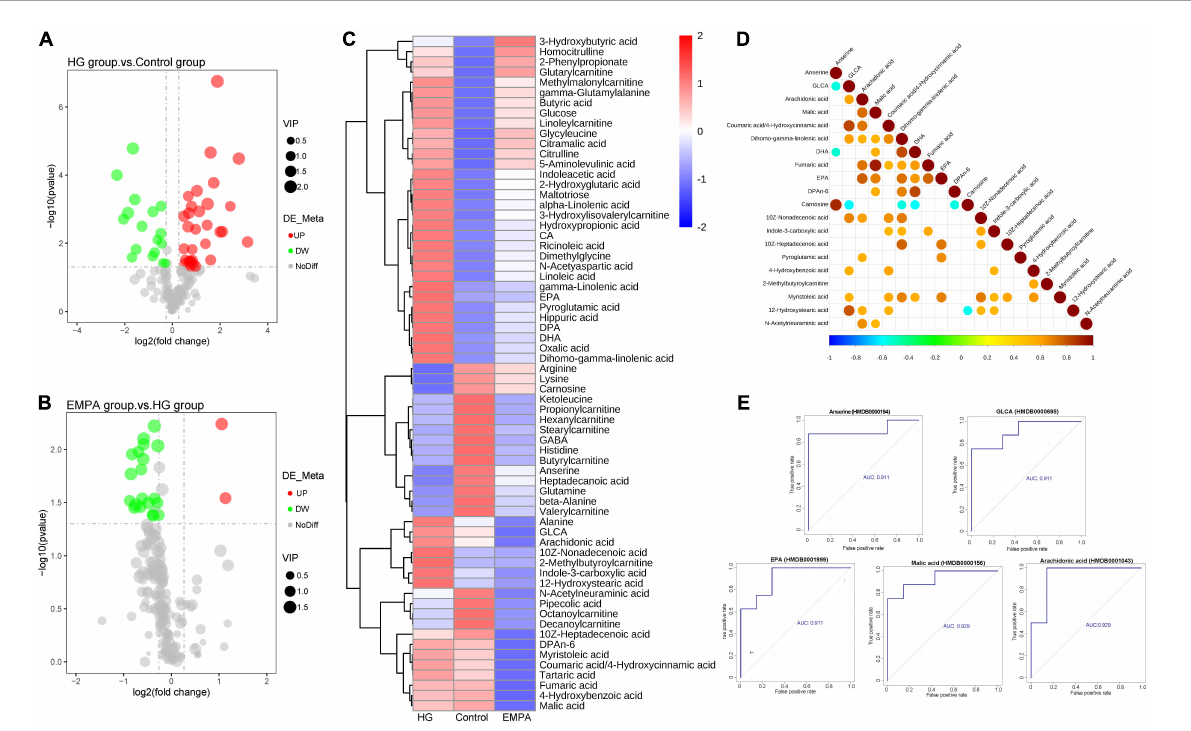
FIGURE4 The differential metabolite of the myocardium. (A,B) Volcano plots of differential metabolite. (A) High glucose (HG) group vs. control group; (B) empagliflozin (EMPA) group vs. HG group. Cut-off value: p < 0.05, fold change (FC) > 1.2 (upregulation) or < 0.67 (downregulation), the red and green point represents the upregulated and downregulated proteins, respectively. (C) Hierarchical clustering analysis of differential metabolite of myocardium in three groups. (D) The correlation diagram of differential metabolites in groups EMPA and HG (top 20). The blue point represents a negative correlation (negative value), and the red represents a positive correlation (positive value). (E) Receiver operating characteristic (ROC) curves of top 5 metabolites [top 5 areas under the curve (AUC)]. The vertical coordinate is the true positive rate (sensitivity), and the horizontal coordinate is the false positive rate